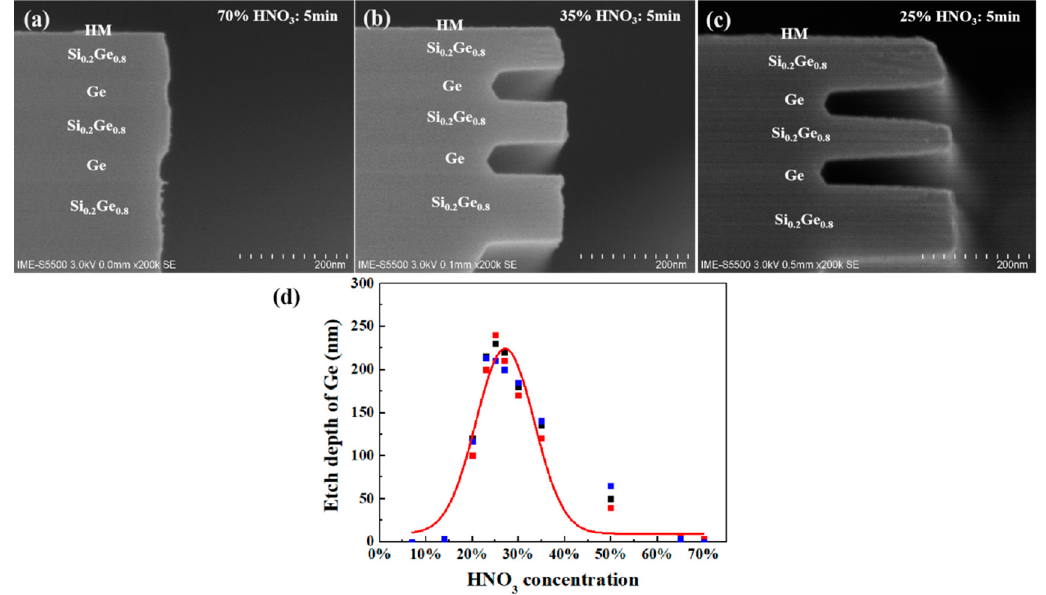
Figure 7. The SEM cross-section images of the Ge buffer/Si 0.2 Ge 0.8 /Ge stack structure in HNO 3 solution for 5 min in different concentrations: ( a ) 70% HNO 3 , ( b ) 35% HNO 3 and ( c ) 25% HNO 3. ( d ) Etching rate of germanium in HNO 3 solution as a function of HNO 3 concentration.